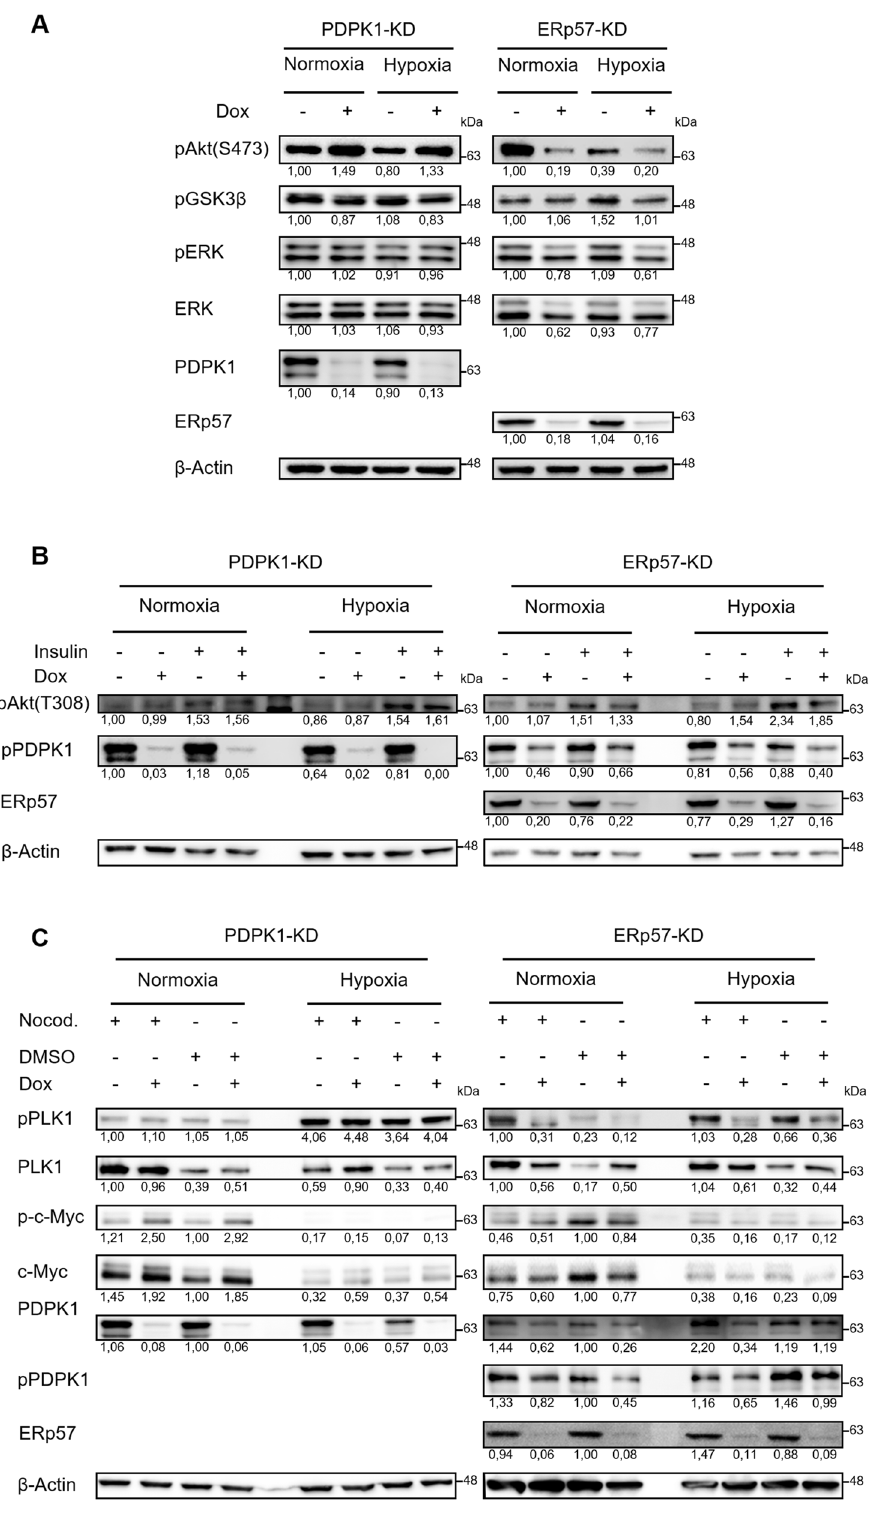
Figure 5. KD of ERp57, but not PDPK1, impairs multiple proliferation factors independently of cellular oxygen levels. ( A )–( C ) Comparison of different proliferation factors in ERp57 KD and PDPK1 KD cells 96 h after induction of KD. ( B ) Cells were treated with 1 mM insulin 3 h before lysis. ( C ) To analyze pPLK1 in the G2/M phase, cells were treated with 0.1 µg/ml nocodazole 16 h before lysis. DMSO was used as a vehicle